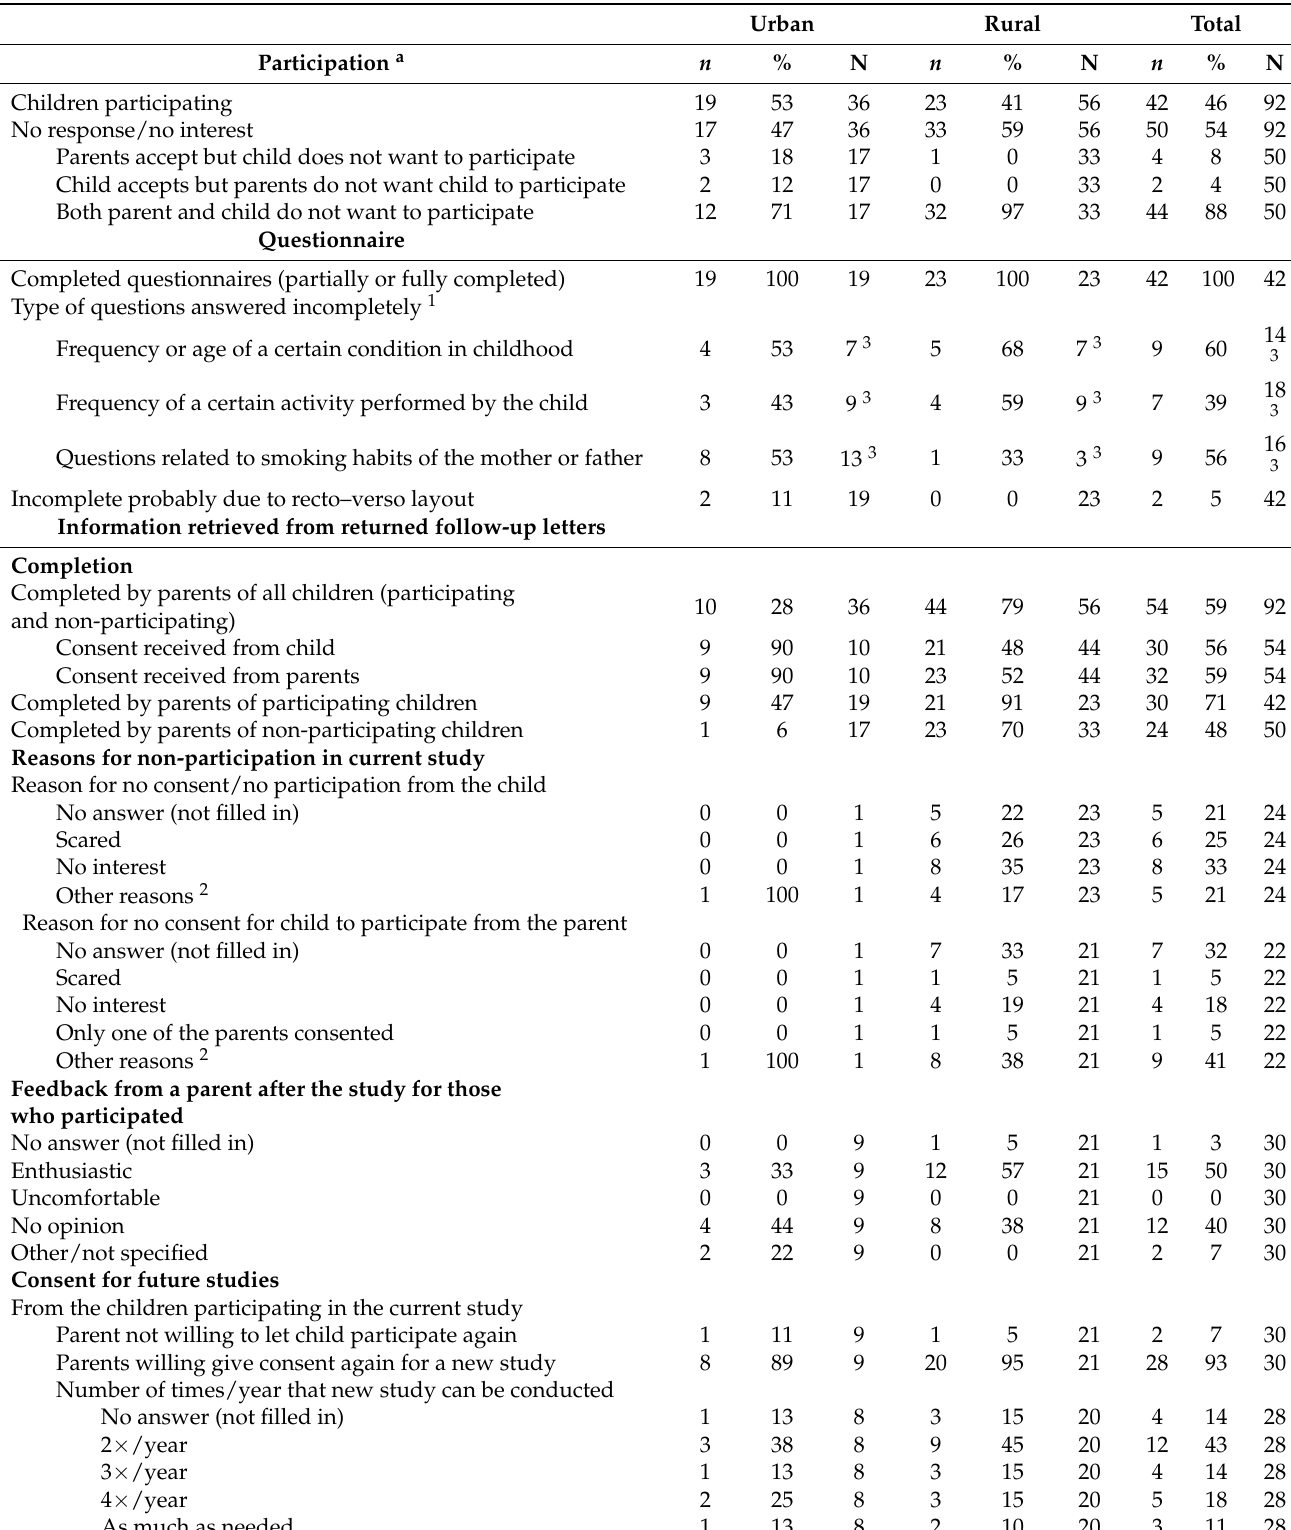
Table 1. Overview of field study participation rate and information retrieved from questionnaire and follow-up